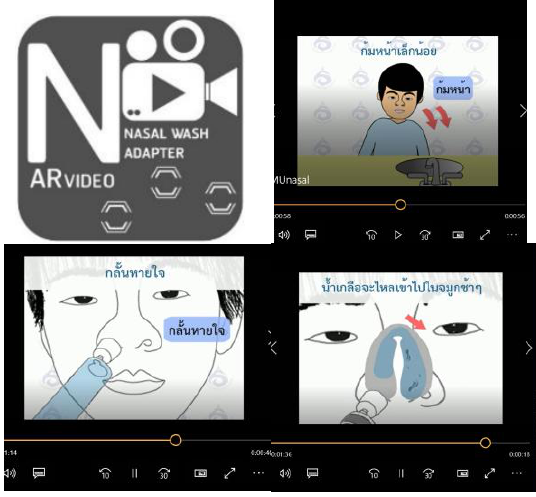
Figure 7 . The nasal wash AR code for